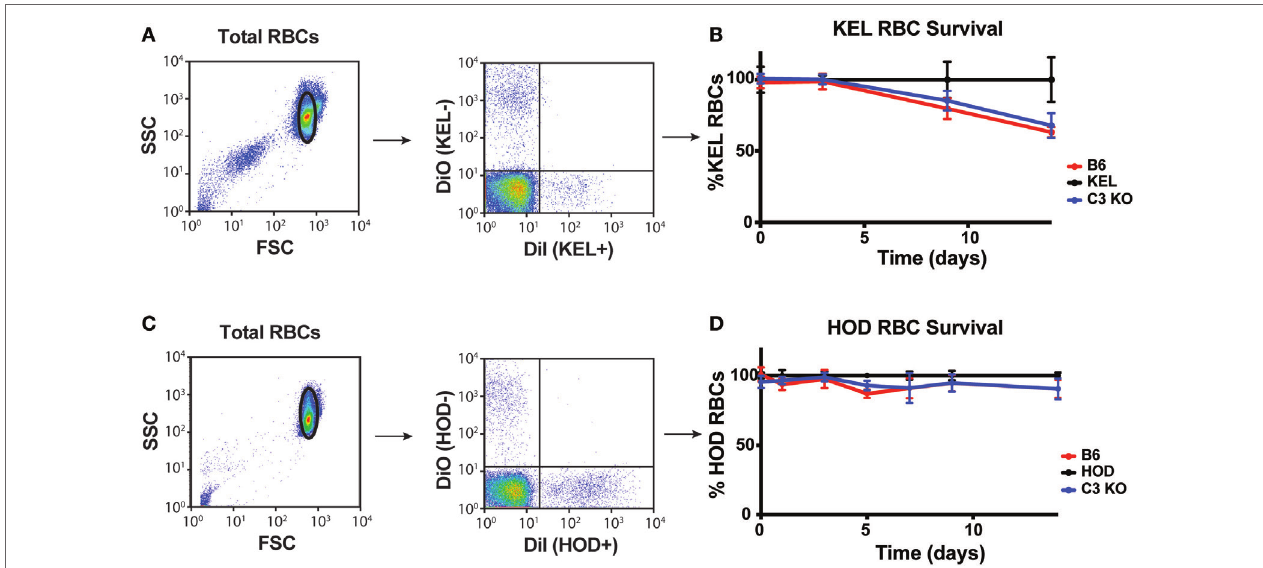
FigUre 6 | Complement component 3 (C3) fails to induce detectable alterations in KEL or HOD red blood cell (RBC) clearance post-transfusion. (a) Gating strategy of KEL + or KEL − RBCs post-transfusion, where the percentage of KEL + RBCs was directly compared to KEL − RBCs in each recipient. (B) KEL + RBC survival was calculated as a ratio of KEL + RBC to KEL − RBC in KEL mice, B6 or C3 KO recipients at the times indicated. (c) Gating strategy of HOD + or HOD − RBCs post-transfusion, where the percentage of HOD + RBCs was directly compared to HOD − RBCs in each recipient. (D) HOD + RBC survival was calculated as a ratio of HOD + RBC to HOD − RBC in HOD mice, B6 or C3 KO recipients at the times indicated. (B,D) RBC clearance was not significant between B6 and C3 KO recipients for KEL RBC (B) or HOD RBC (D) clearance by two-way ANOVA with Dunnett’s multiple comparisons test. Means ± SD